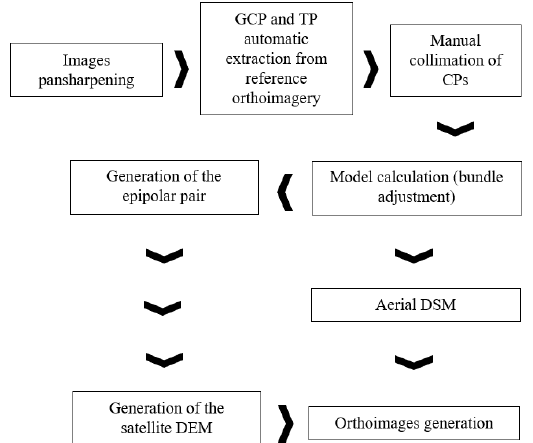
Figure 2. Adopted photogrammetric workflow for satellite stereo